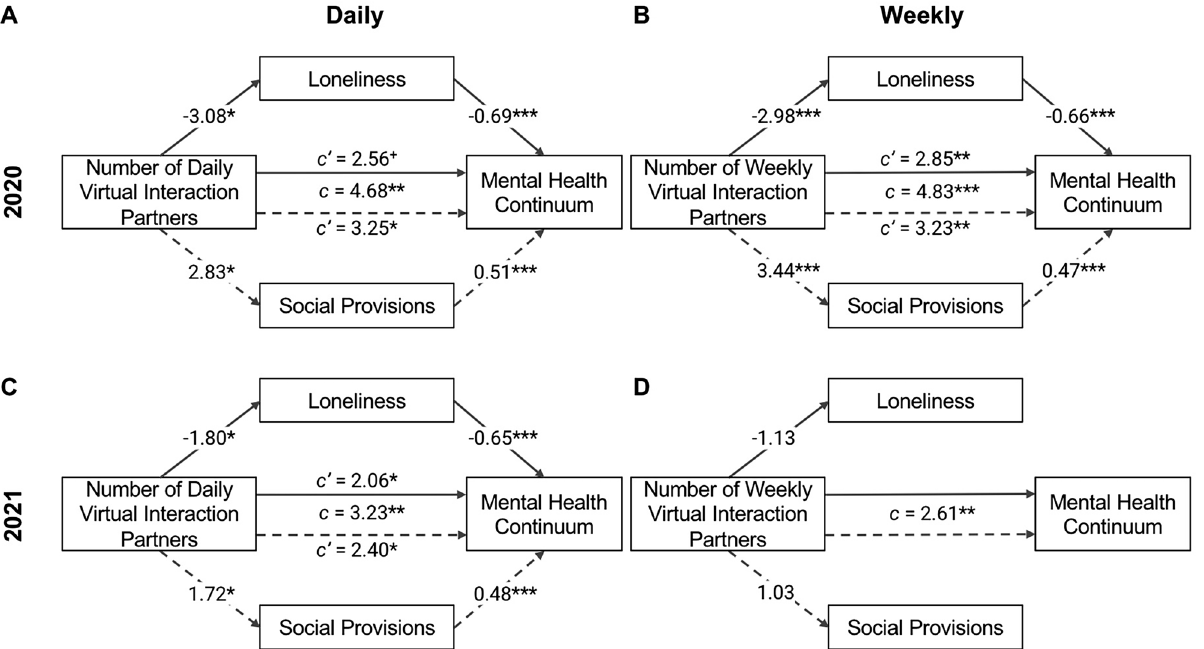
Figure 2. Reduced loneliness and greater perceived support mediate the positive relationship between number of virtual interaction partners and mental health. Simple mediation analyses were performed on the positive relationship between mental health and number of interaction partners. Regression coefficients and associated significance levels for these analyses are shown. The relationship between interaction partners and mental health was statistically mediated by reduced loneliness and increased perceived social support in all models, except for the relationship between mental health and weekly interaction partners in 2021. Note that number of weekly interaction partners in 2021 was not predictive of either loneliness or social provisions, so no further mediation analyses were performed. * p < 0.050, ** p < 0.010, *** p <